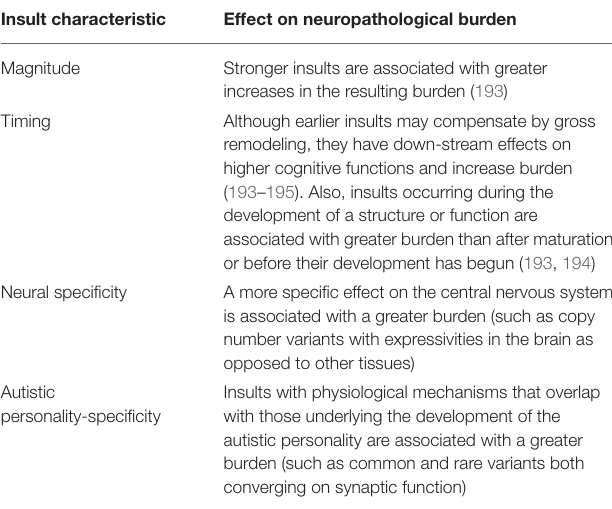
TABLE 2 | Insult characteristics and their effects on the neuropathological